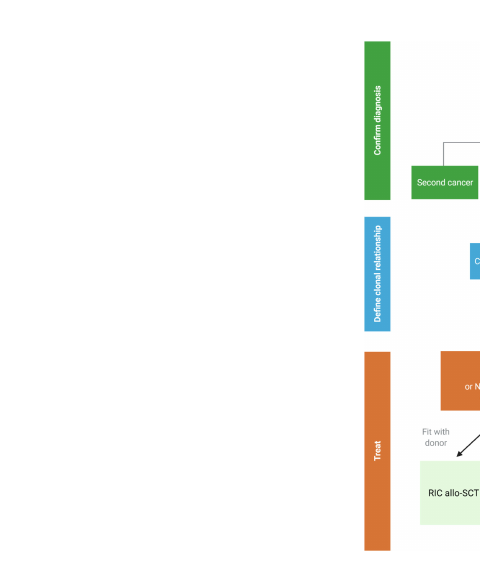
FIGURE 3 | Proposed algorithm for the management of suspected diffuse large B-cell Richter transformation (DLBCL-RT). aCLL, accelerated chronic lymphocytic leukemia; auto-SCT, autologous stem cell transplantation; DLBCL, diffuse large B-cell lymphoma; NA, novel agents; RIC allo-SCT, reduced intensity conditioning stem cell transplantation. Created with